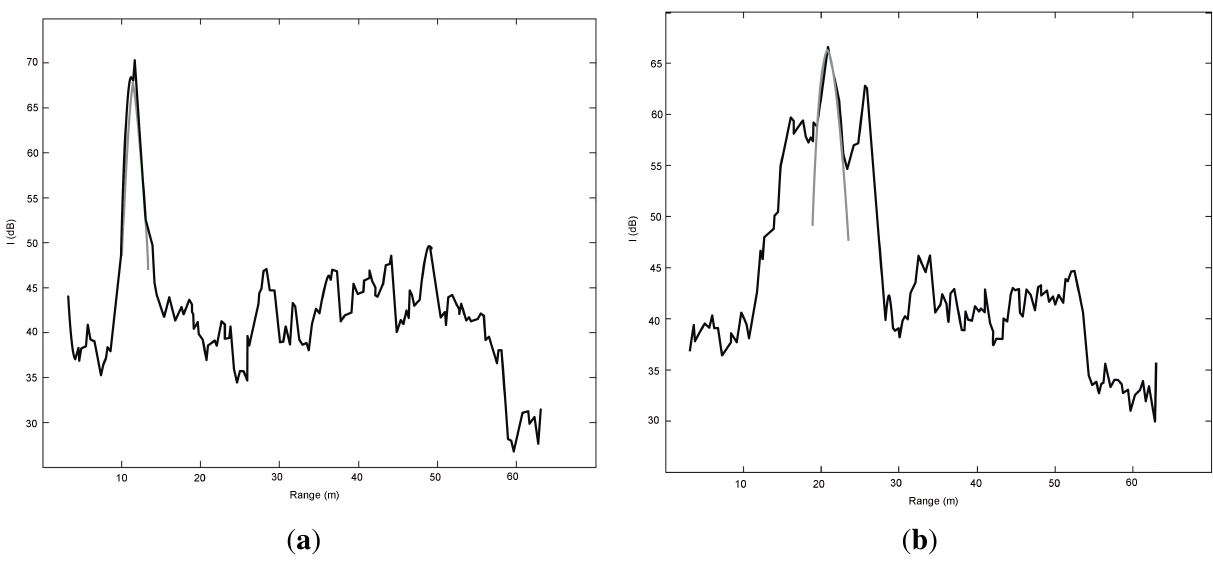
Figure 7. Examples of false positives: an obstacle would be erroneously labeled as ground considering only the SE ( a ); an obstacle in the vicinity of ground would be flagged as ground ( b ). Black: radar observation. Grey: RCGD ground echo model.